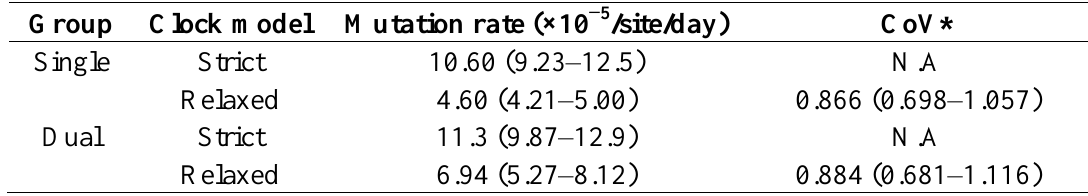
Table 1. Mutation rates of FIV genome in single and dual infected cats.